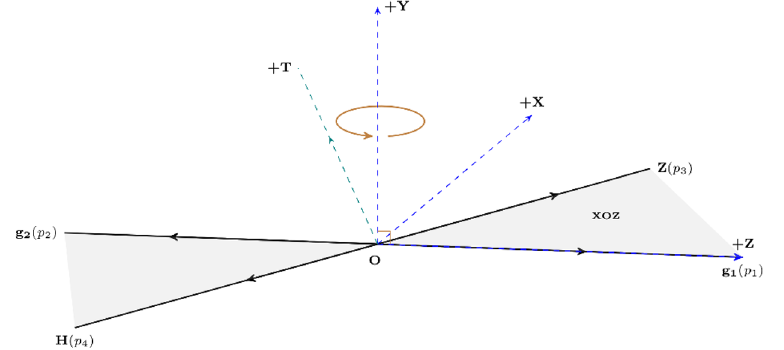
Figure 2 . The coordinate system in the center-of-mass frame of the two incoming